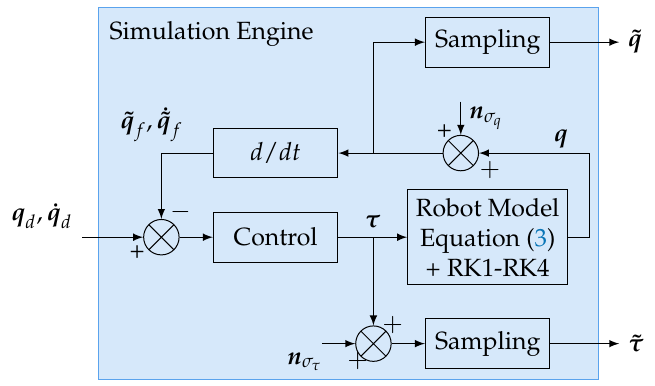
Figure 7. Detail of the “ Simulation Engine ” of Figure